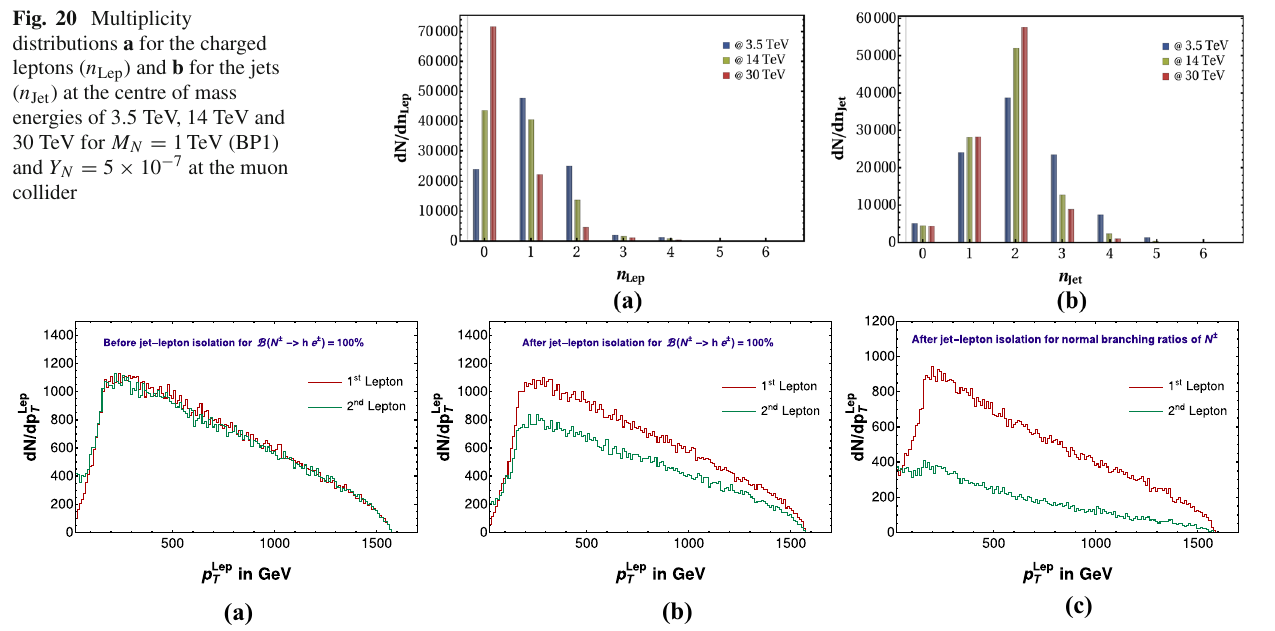
Fig. 20 Multiplicity distributions a for the charged leptons ( n Lep ) and b for the jets ( n Jet ) at the centre of mass energies of 3.5 TeV, 14 TeV and